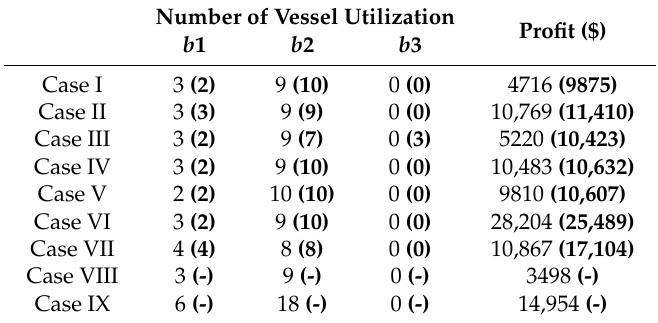
Table 4. Summary of profit and vessel utilization; deterministic